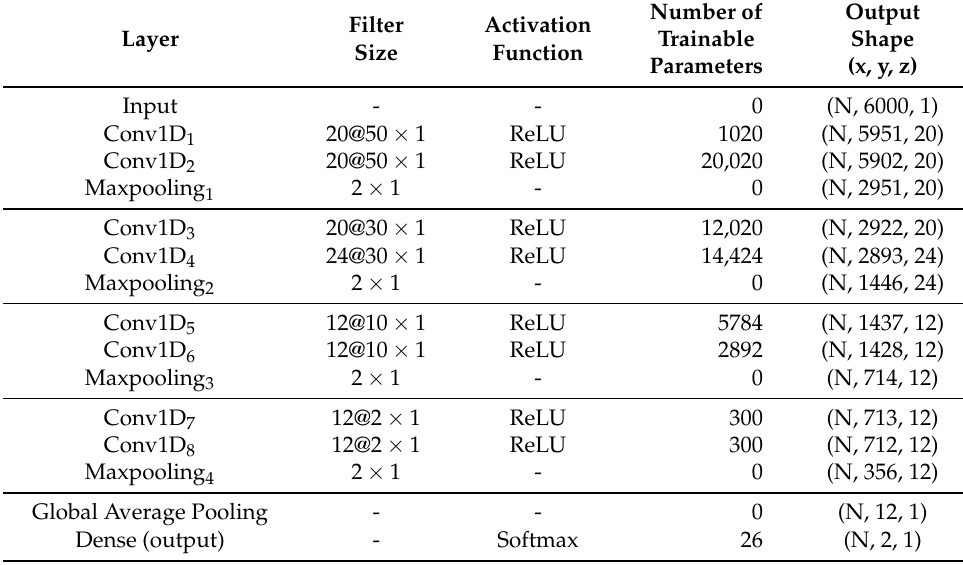
Table 3. Detailed settings of the proposed 1D CNN networks.